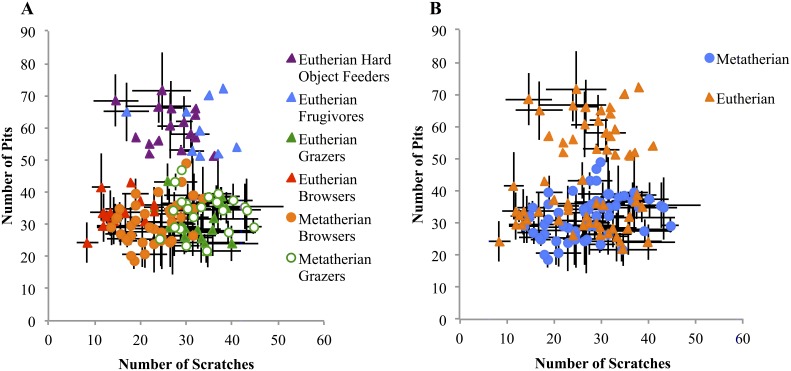
Microwear patterns of marsupial and placental herbivores plotted according to feeding guild (A) and phylogeny (B).Note, the partial separation between marsupials and placentals in B is only based upon the absence of obligate hard object feeders (and, thus, of elevated pit counts) among marsupials in the data set. The three dietary groupings in A are significant (p<0.01). Marsupial and placental herbivores of comparable guilds are statistically indistinguishable (p = 0.84).